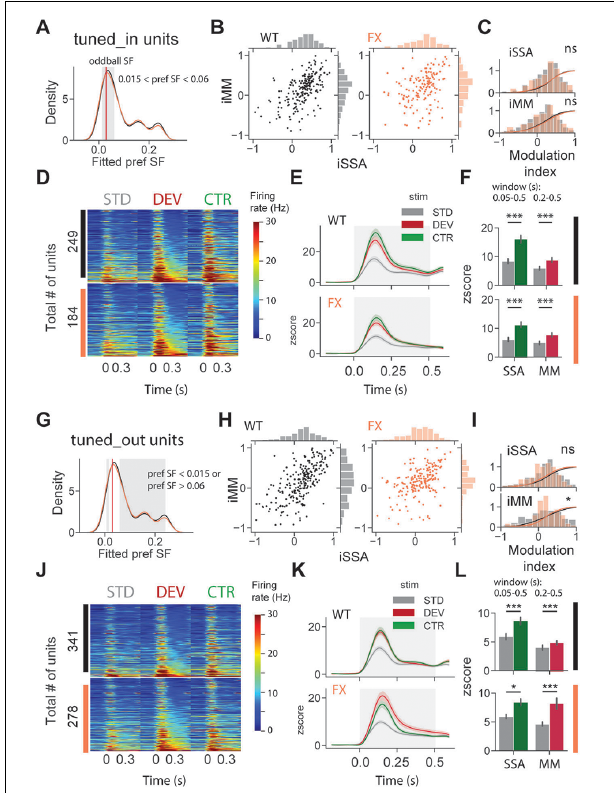
FIGURE 4 | SSA and MM are present in single units tuned to various spatial frequencies of both genotypes. (A) Distribution of preferred SF of two different genotypes. Gray shaded area represents tuned_in group, which included units with preferred SF that lies ± 1 octave of oddball SF (0.03, red vertical line). (B) Distribution of iSSA and iMM modulation indices for WT and FX mice (each point is a single unit). (C) Superimposed distributions of iSSA and iMM with KDE. (D) The heatmaps show single-unit firing rates in response to STD, DEV, and CTR stimuli across different genotypes. ( E ) The line plots show the mean z -scored responses of the units from the heatmaps. (F) The point plots show the mean ± SEM of the z -scored firing rate between 0.05 and 0.5 s for SSA and 0.2–0.5 s for MM relative to the stimulus onset. (G–L) Same as in (A–F) but for units which preferred SF was outside 1 octave of the oddball SF. ∗ p < 0.05, ∗∗∗ p < 0.001, ns = not significant.